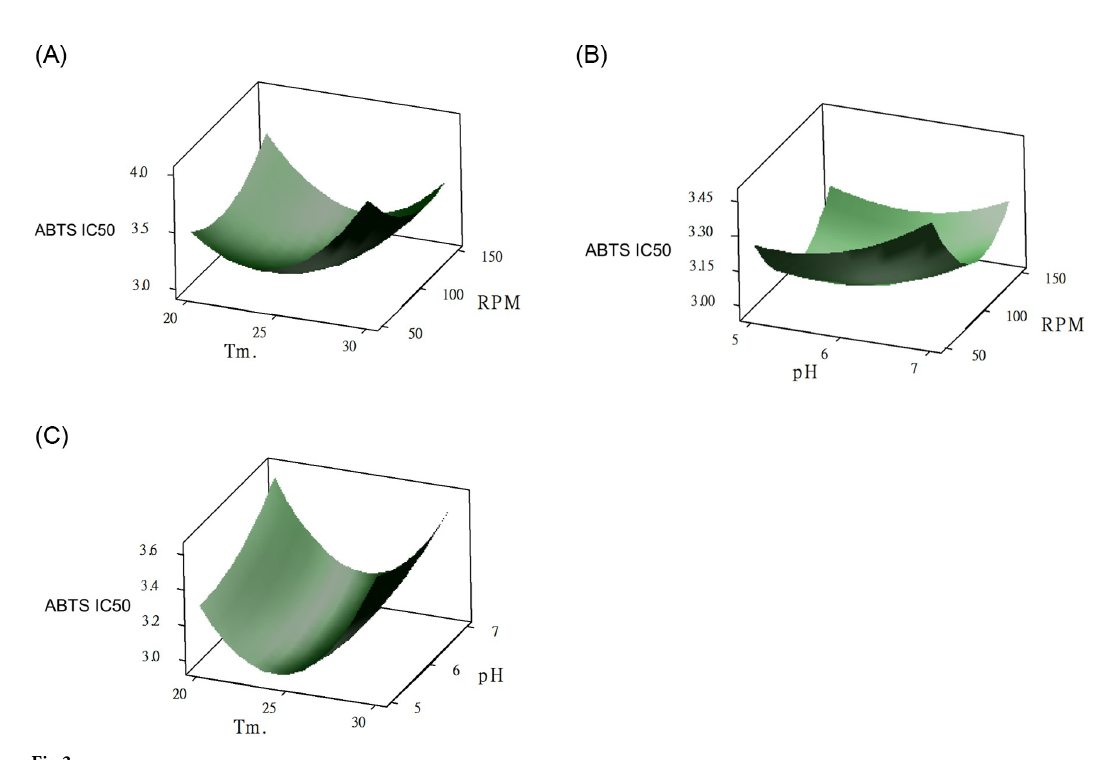
(Table 4). Compared to the TPC in the unfermented djulis samples, that in the fermented sam- ples exhibited a significant increased from 9.33 to 28.97 (mg of gallic acid/gdw) (p < 0.05). (Table 4).